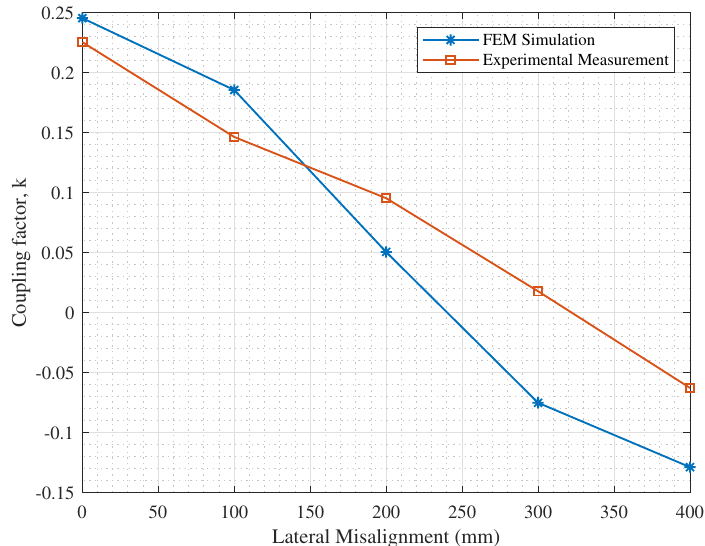
Figure 14. Simulation vs. experimental results of coupling factor, k , at different lateral